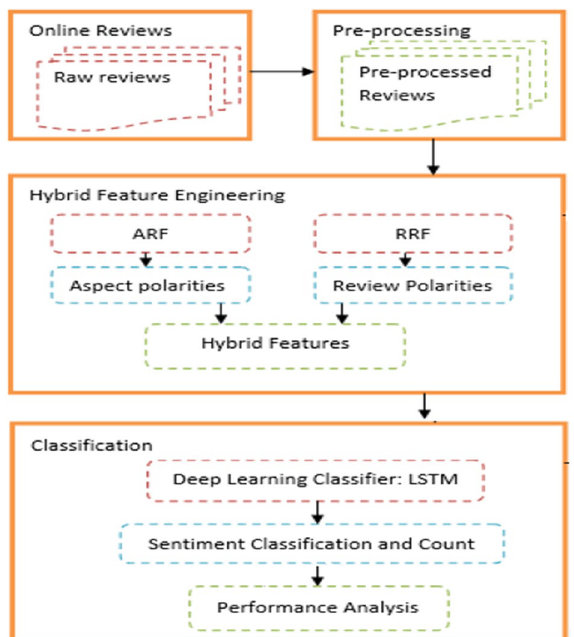
Fig. 1 Proposed architecture for SA using HFV